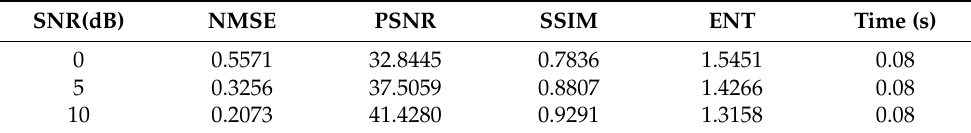
Table 10. Quantitative performance evaluations using 10% available